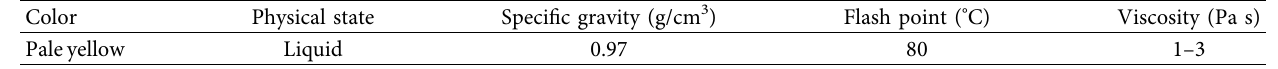
Table 7: The properties of ZycoTherm used.